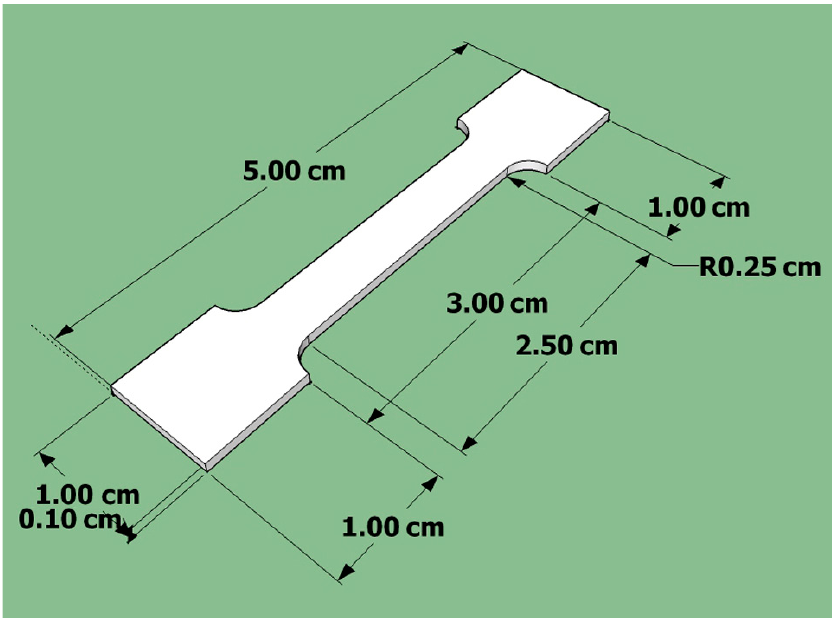
Figure 2. Dimensions of the tensile specimens.